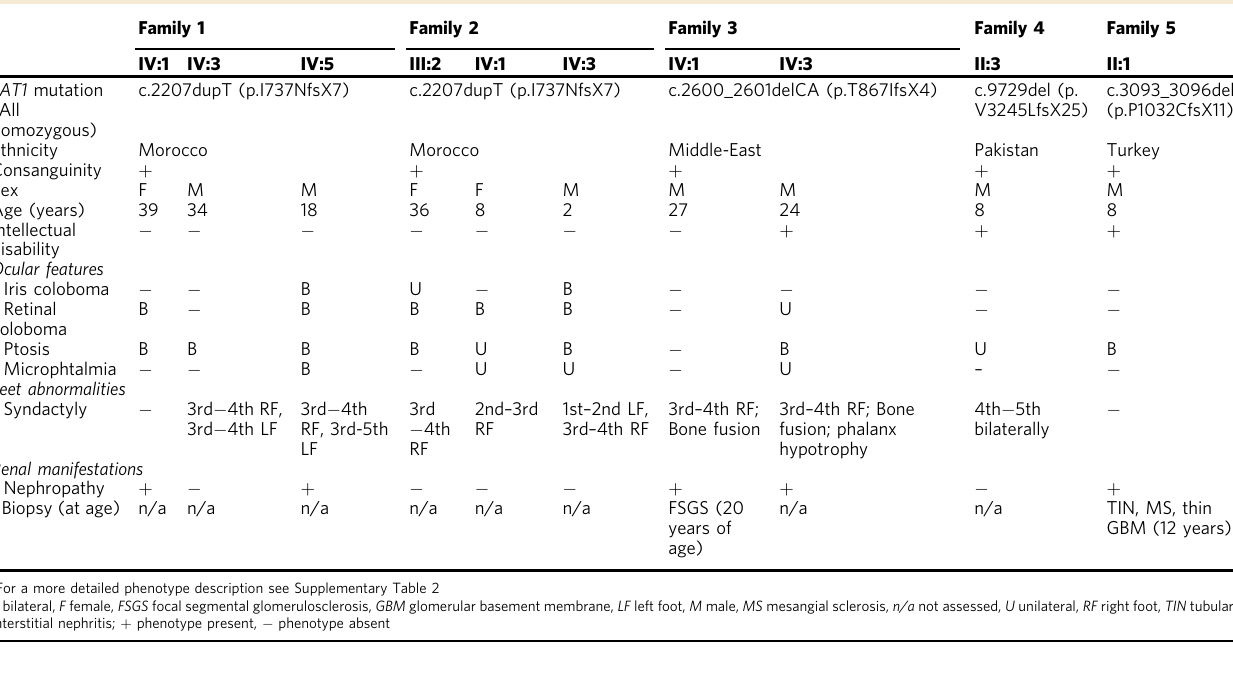
Table 1 Clinical characteristics of homozygous FAT1 mutations carriers